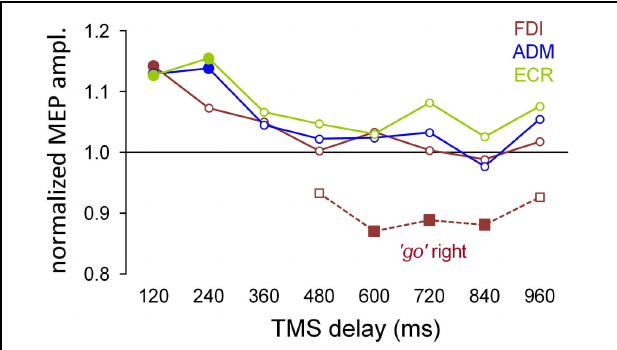
FIGURE 4 | Mean MEP amplitudes across subjects as a function of TMS delay with respect to stimulus onset. The data values for the ADM and ECR muscles were averaged irrespective of the ocular task and cue side. By contrast, MEP amplitudes of the FDI muscle from the ‘go’ trials with targets on the right side were averaged separately (squares) because they were significantly smaller than in the other experimental conditions (see text). Filled symbols denote a statistically significant difference from the baseline (one-sample t -test; P < 0.05). Values higher than unity indicate MEP amplitudes larger than